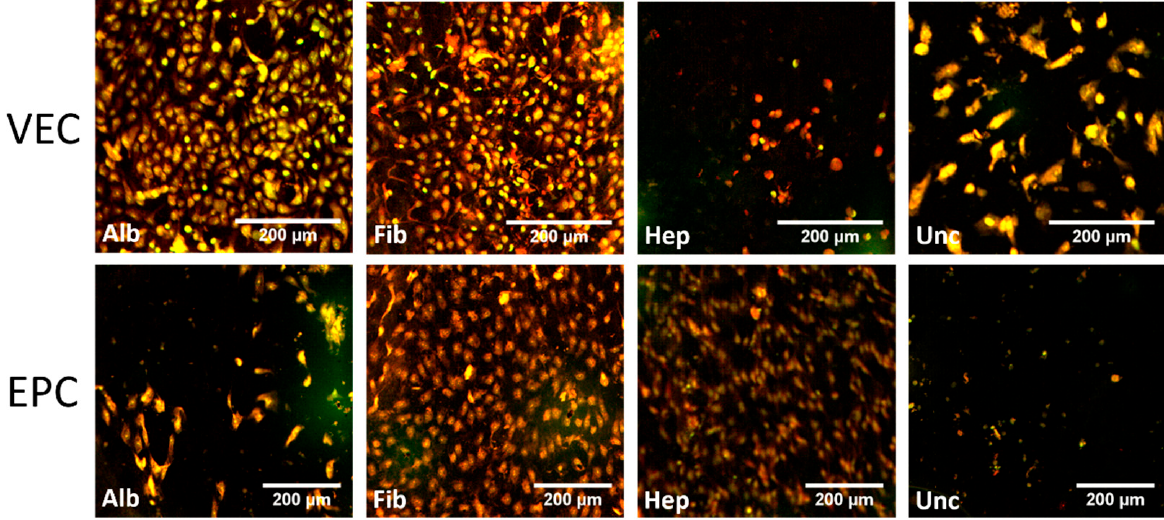
Figure 5. The image shows the luminal side of a sliced and spread out section of the tubular BNC graft seeded with vascular endothelial cells (VECs, upper row) and endothelial progenitor cells (EPCs, bottom row) after 96 h of dynamic cultivation, stained with acridine orange. All images reflect the exemplary regions that are labelled in Figures S3 and S4. Islands with high cell density of VECs were only found on albumin- and fibronectin-coated grafts, with lower density on uncoated grafts. The EPCs grew to highly dense populated areas only on fibronectin- and heparin-coated grafts, whereas the albumin and uncoated groups only showed isolated cells and cell groups. Alb—albumin, Fib—fibronectin, Hep—heparin,